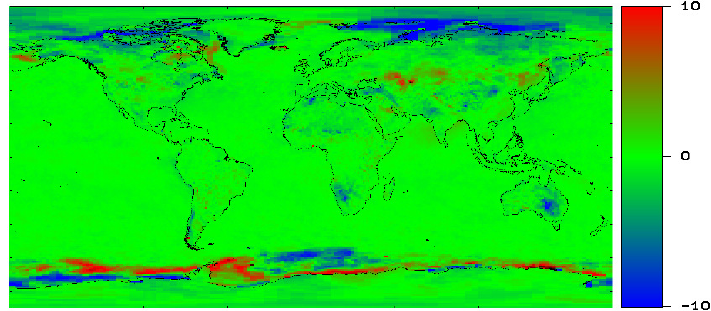
Figure 5. Clear-sky RSR for period 08/2009–07/2018 minus 08/2000–07/2009. The scale is in W/m 2